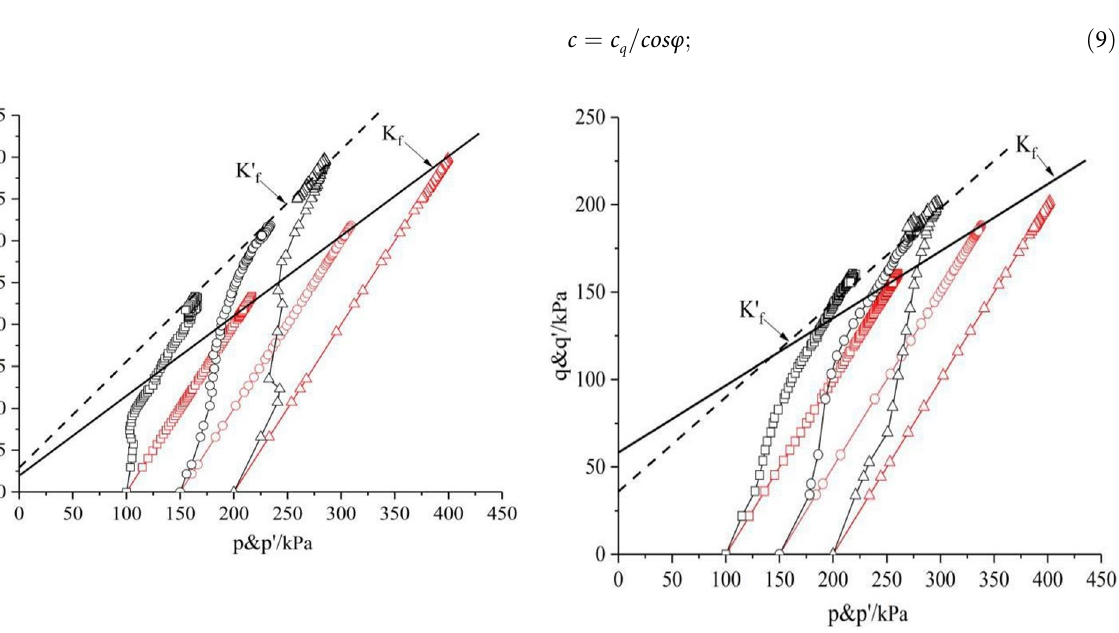
= 1.5 g/cm 3 and ρ = 1.6 g/cm 3 . (a) Shear rate v = 0.04 mm/min . (b) Shear rate 0.04 mm/min . d d